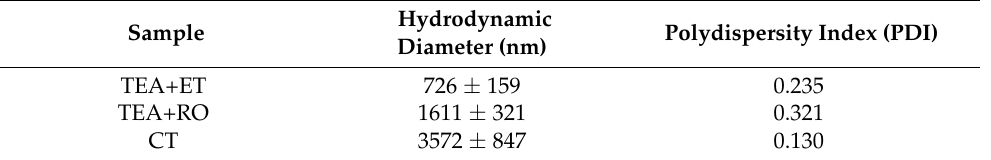
Table 2. Hydrodynamic diameter and polydispersity index of different experimental groups mea- sured by DLS in absolute ethanol (Detection immediately after preparation).